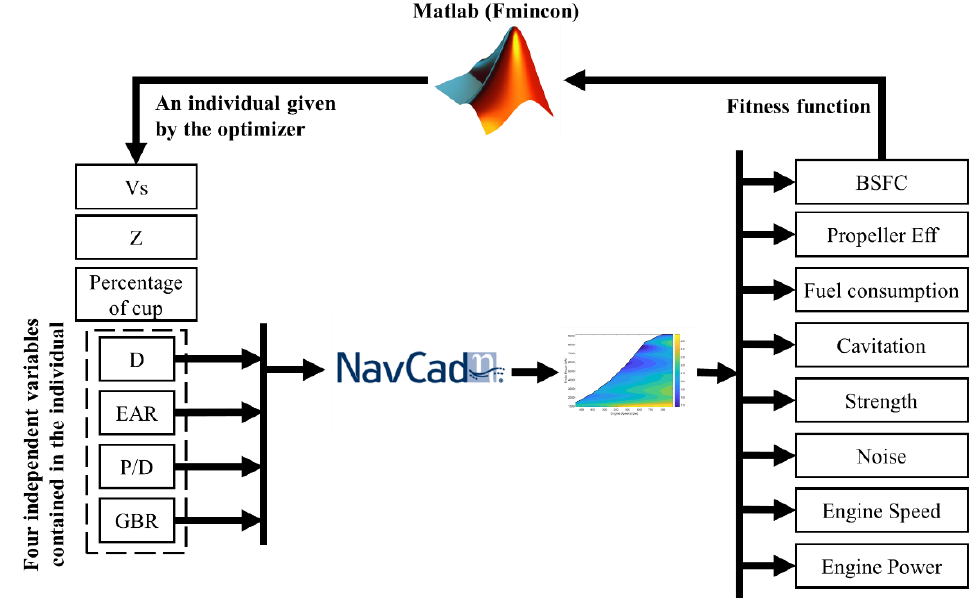
Figure 2. Schematic diagram of the propeller optimization model [20].